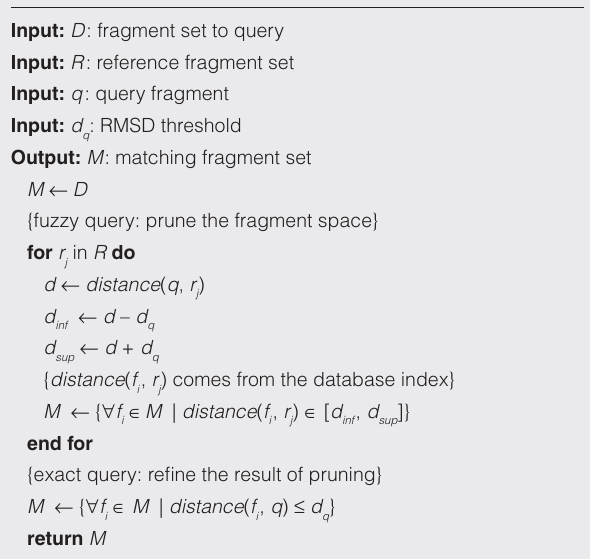
Algorithm 1. Query with a fragment and an RMSD threshold. Comments are enclosed between